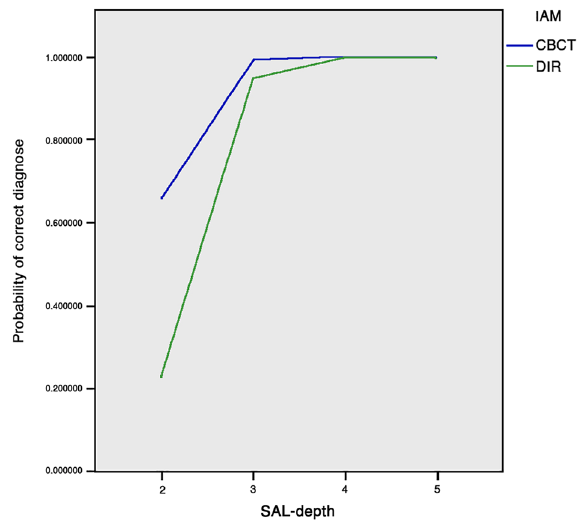
Figure 7. Relationship between image acquisition method (IAM), simulated apical lesion (SAL) depth, and SAL diagnose (2 = 50% of the bur diameter [0.7 mm Ø] in cancellous bone; 3 = 100% of the bur diameter in cancellous bone[1.4 mm Ø]; 4 = bur through cancellous bone up to cancellous cortical bone boundaries; 5 = cortical bone perforated [visible